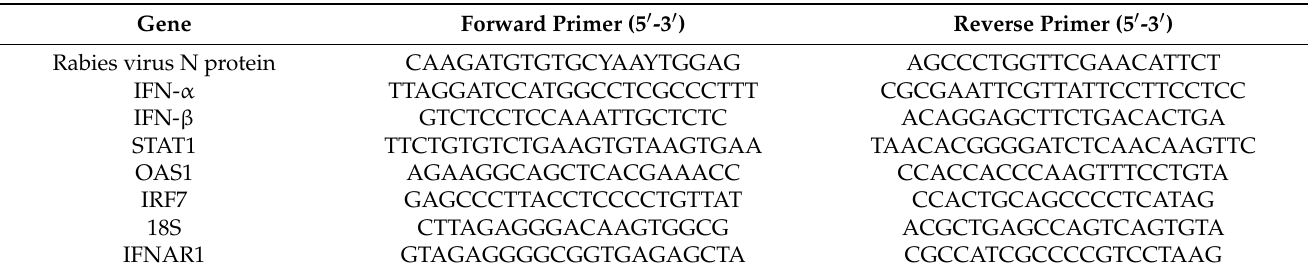
Table 1. List of primers used for quantitative reverse transcriptase PCR. Gene Forward Primer (5 (cid:48) -3 (cid:48)